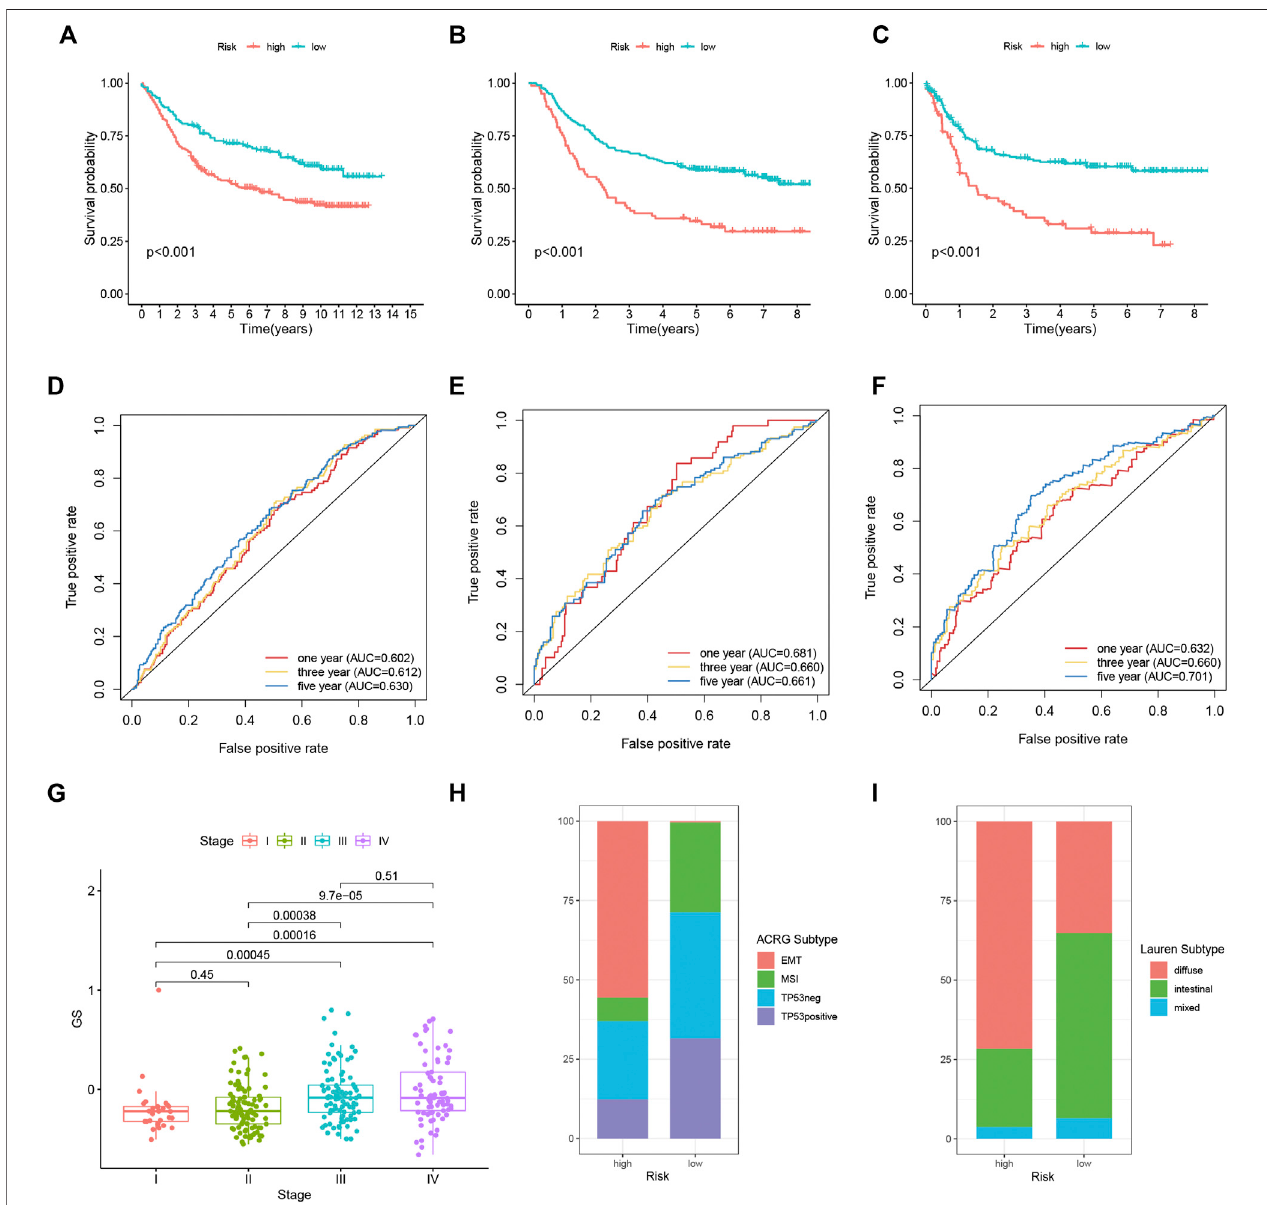
FIGURE 8 | External validation of the FRLP risk score model in two GEO cohorts using the alternative GS model. Kaplan – Meier plots comparing OS of high- and low-risk patients in GSE84437 (A) and GSE62254 (B) . (C) Kaplan – Meier plots comparing disease-free survival (DFS) of high- and low-risk patients in GSE62254. ROC analysis of the GS model in predicting 1, 3, and 5 year OS in (D) GSE84437 and (E) GSE62254. (F) ROC analysis of the GS model in predicting 1, 3, and 5 year DFS in GSE62254. (G) Boxplots comparing GS score differences among different stages of patients in GSE62254. (H,I) Barplots showing the relative proportion of four Asian Cancer Research Group (ACRG) subtypes and three Lauren subtypes in high- and low-risk patients in GSE62254.